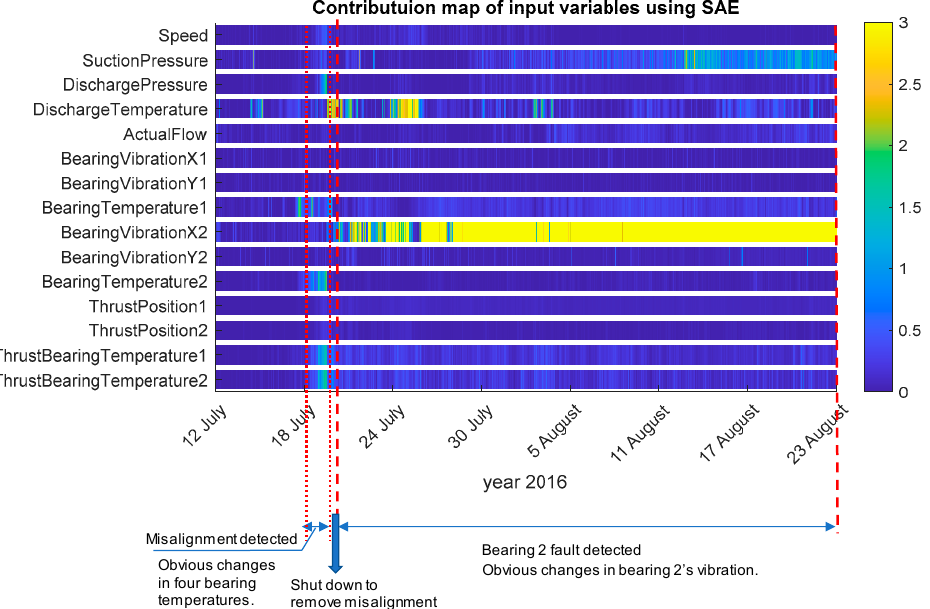
Figure 14. Contribution map by the SAE model from 12 July 2016 to 23 August 2016.